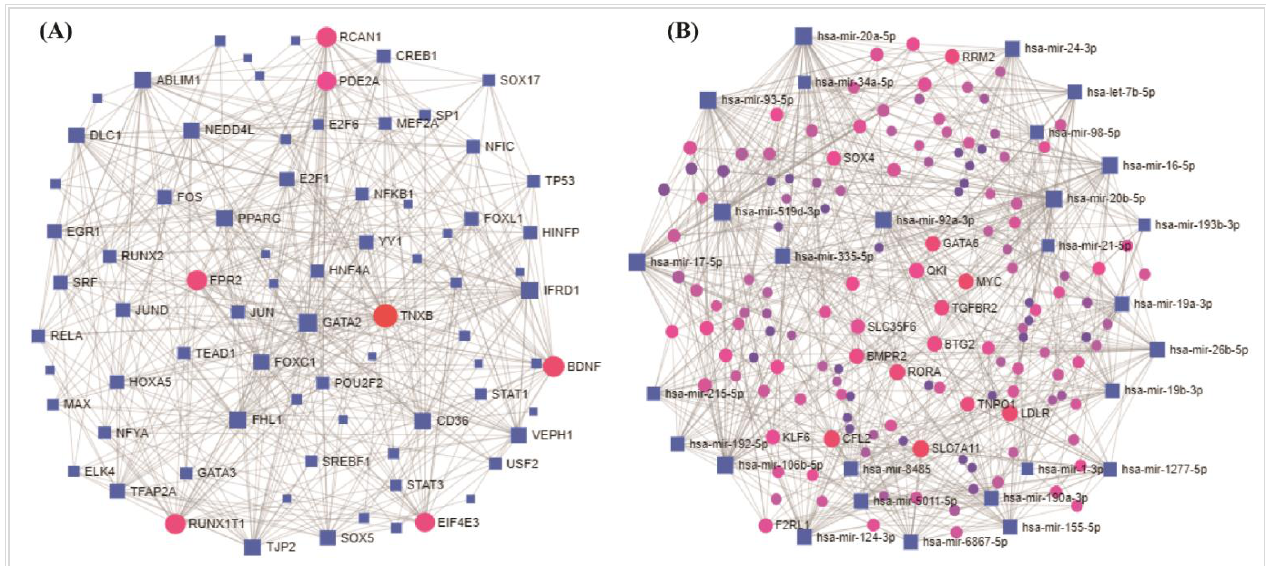
Figure 6. ( A ) The TFs-DEGs interaction network and ( B ) the miRNA-DEGs interaction network. The TFs and miRNAs are marked as blue-shape square in the interactions. The larger square means a higher degree of connectivity among the nodes. The circle-shaped nodes represent the DE genes.